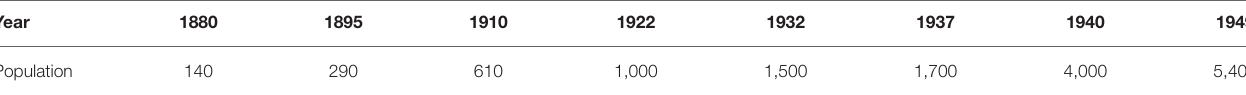
TABLE 1 | Increase of the population in Shanghai concessions (thousands) Zhang